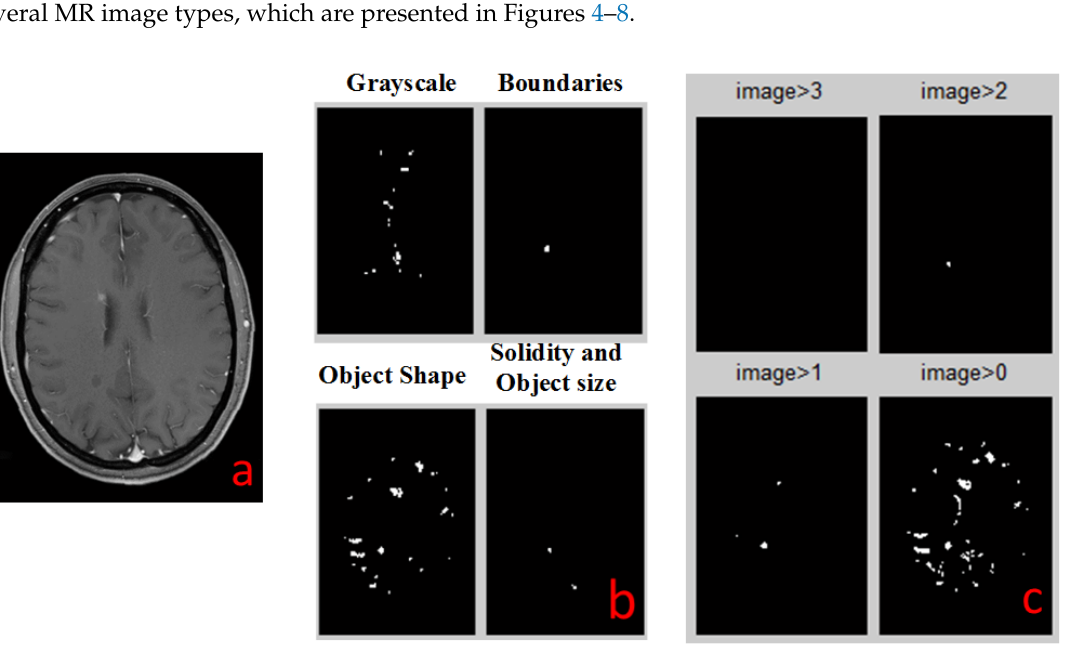
Figure 3. Detection algorithms: ( a ) boundaries detection scheme; ( b ) object shape detection scheme; ( c ) grayscale range detection scheme.